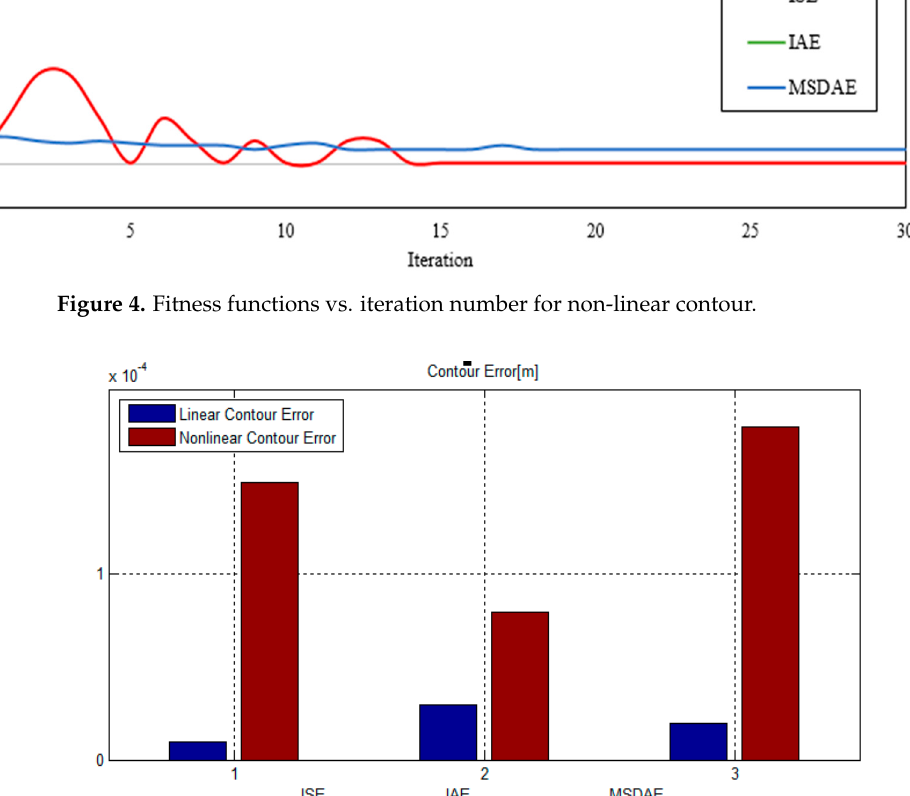
Figure 5. Contour error produced in linear and non-linear contour tracking using gain optimization through fitness functions.